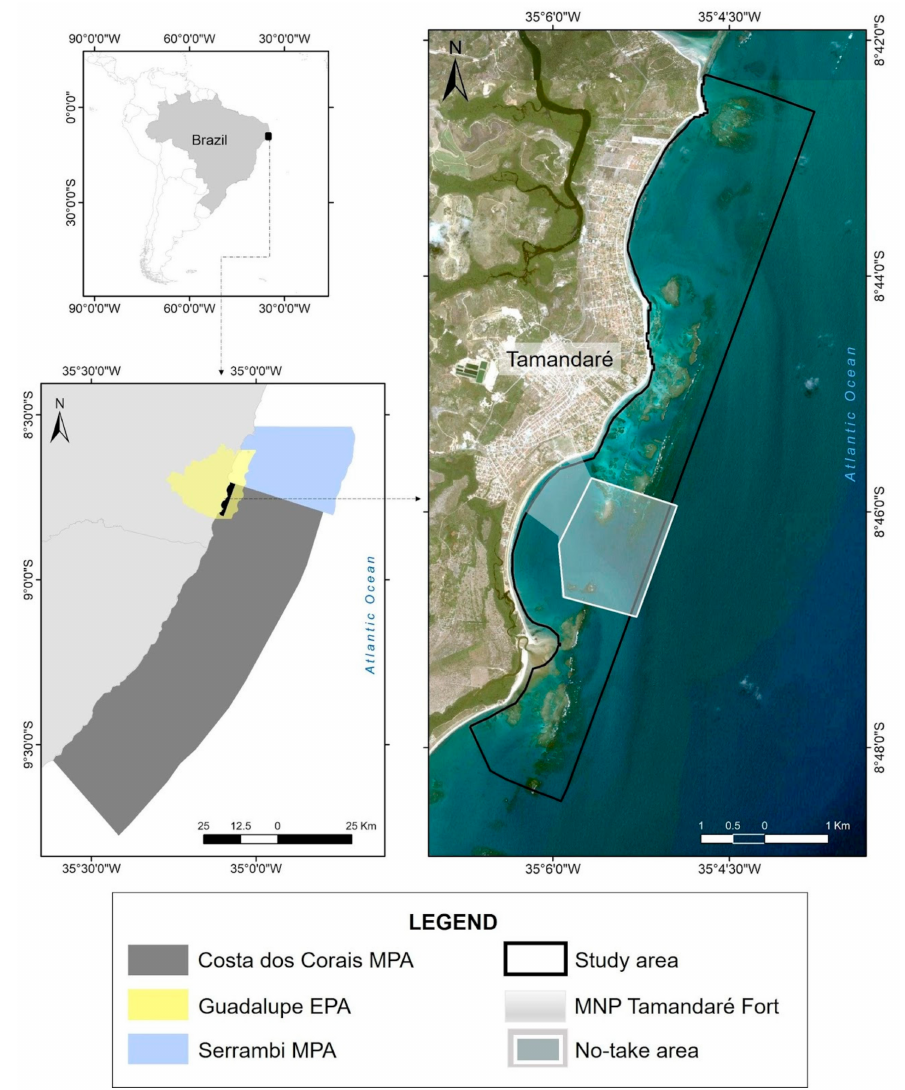
Figure 1. Study area at the coral reefs of Tamandar é (black polygon) and the location of the no-take zone (white outlined polygon) within the Municipal Natural Park (MNP) Tamandar é Fort (white polygon). The map on the left also shows the location of the three mosaic-organized marine protected areas (MPAs): Costa dos Corais MPA (grey polygon), Serrambi MPA (light blue polygon) and Guadalupe Environmental Protected Area (EPA) (yellow polygon). Background image: Google